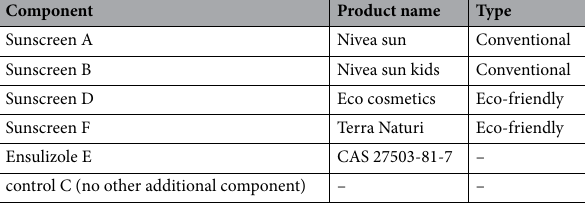
Table 1. Sunscreens used.